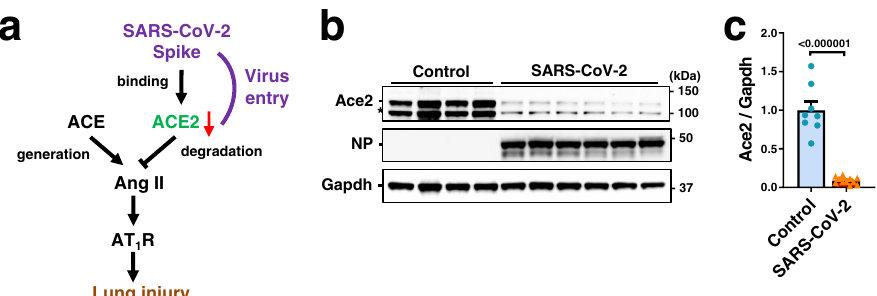
Fig. 1 Downregulation of ACE2 expression in hamster lung by SARS-CoV-2. a Schematic drawing of renin-angiotensin system (RAS) and ACE2 in lung injury. Downregulation of ACE2 expression in SARS-CoV-2 infection is implicated by the studies on SARS coronavirus. b , c Protein expression of ACE2 in hamster lungs at 4 days after intranasal infection of SARS-CoV-2. Western blot of lung lysates from the hamsters infected with SARS-CoV-2 (UT- NCGM02) ( b ) are shown. NP Nucleocapsid phosphoprotein. * unfolded or short form of ACE2 or non-speci fi c band. Infection with the HKU-001a strain is shown in Supplementary Fig. 1b. Quanti fi cation of ACE2 protein abundance ( c ) was done with combined results of the two virus strains; uninfected control ( n = 8) and SARS-CoV-2 infection ( n = 11). Values are means± SEM. Two-tailed unpaired t -test. Independent experiments were performed one time ( b ) or two times ( c ), and consistent results were